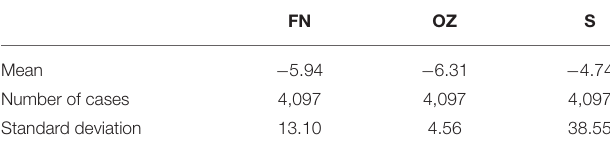
TABLE 2 | Statistic feature of real EEG